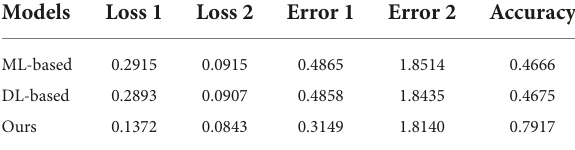
TABLE 3 Comparison of language communication ability evaluation results.